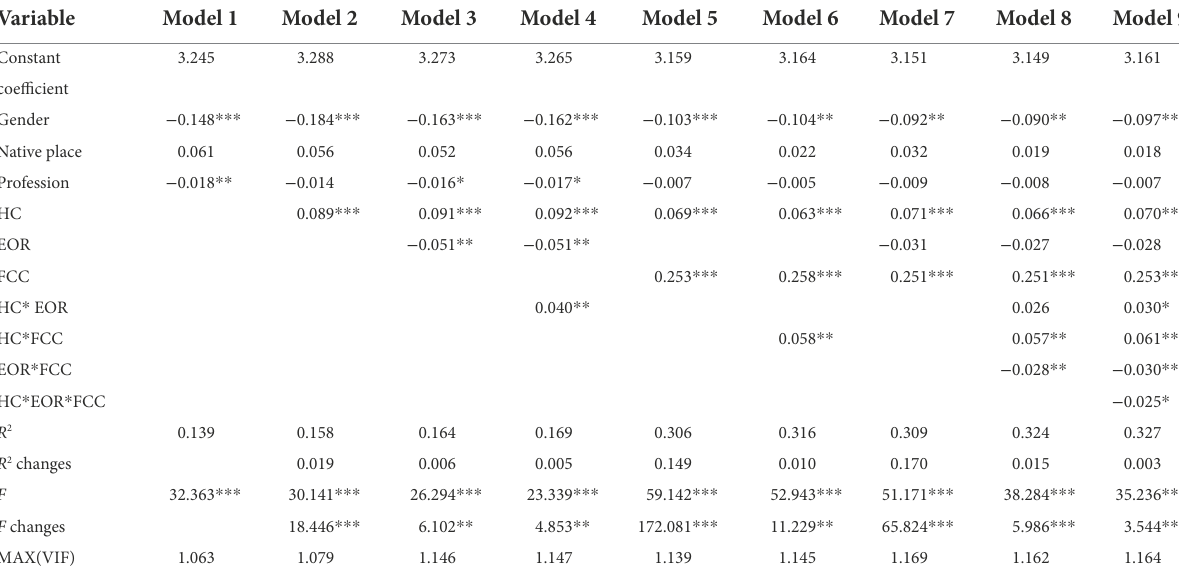
TABLE 3 The moderating effect of perception reduction of employment opportunities under the epidemic and future career clarity on human capital and employability. Dependent variable: